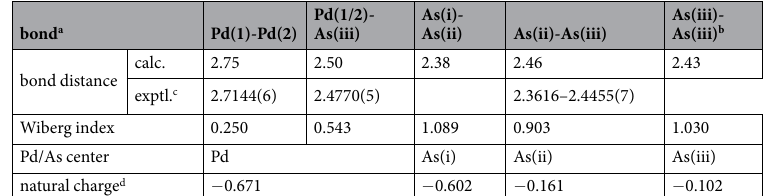
Table 1. Optimized geometric structure of D 2 h [Pd 2 As 14 ] 4 − ( 1 ) cluster at the PBE0/def2-TZVP level. The calculated bond distances (in Å) are compared with those from synthetic experiment. Also presented are the Wiberg bond indices and natural atomic charges (in |e|) via the natural bond orbital (NBO) analysis. a The As atoms in [Pd 2 As 14 ] 4 − ( 1 ) may be classified into three types. As(i): two bridging As atoms; As(ii): four As atoms that are tricoordinated with As; As(iii): eight As atoms linked to the Pd atoms. b Only four As(iii)-As(iii) bonds are present in 1 , which link the two square-planar PdAs 4 units (Fig. 1). c Experimental data from ref. 24. d Charge per Pd or As